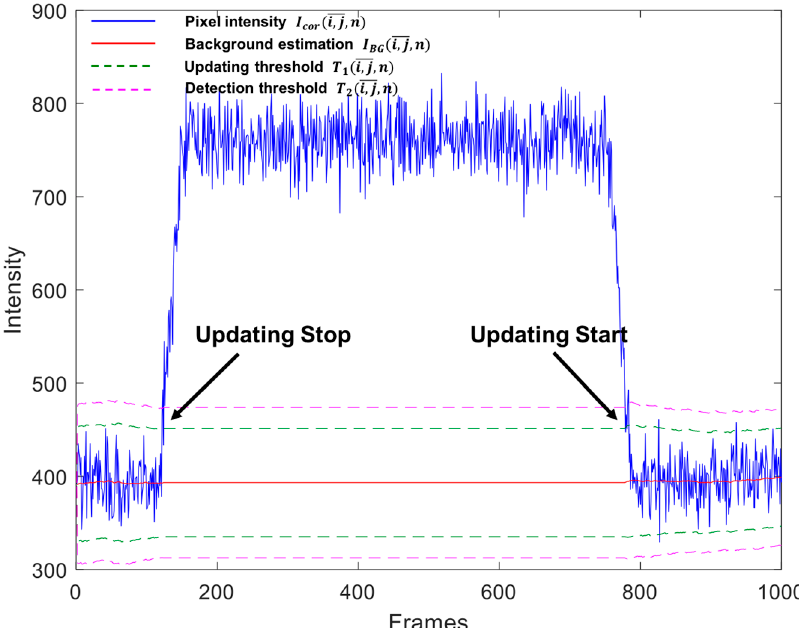
Figure 7. Plot of: the intensity (after the removal of µ ( n ) ), solid blue line; background estimation, solid red line; updating threshold, dashed green lines; and detection threshold, dashed magenta lines over time, for a pixel crossed by a moving object between frames 122 and 784.